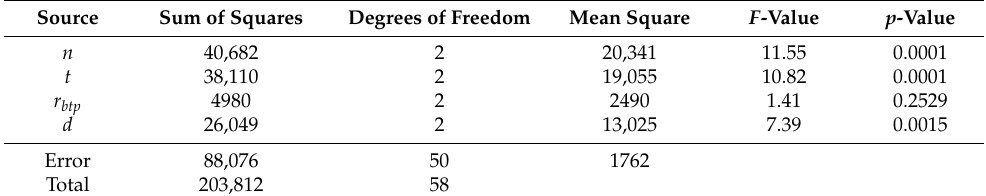
Table 3. Results of the ANOVA for the correlation between the heat of reaction and the milling parameters. Source Sum of